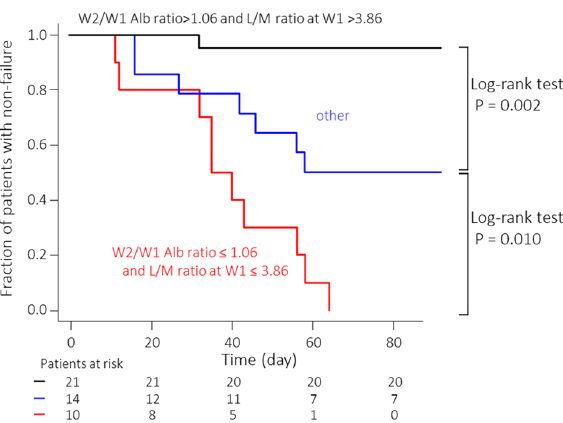
Figure 3. Kaplan–Meier time-to-relapse curve of patients with ulcerative colitis (UC) by group: the week 2 (W2)/week 1 (W1) albumin (Alb) ratio > 1.06 and leukocyte to monocyte (L/M) ratio > 3.86 group, the